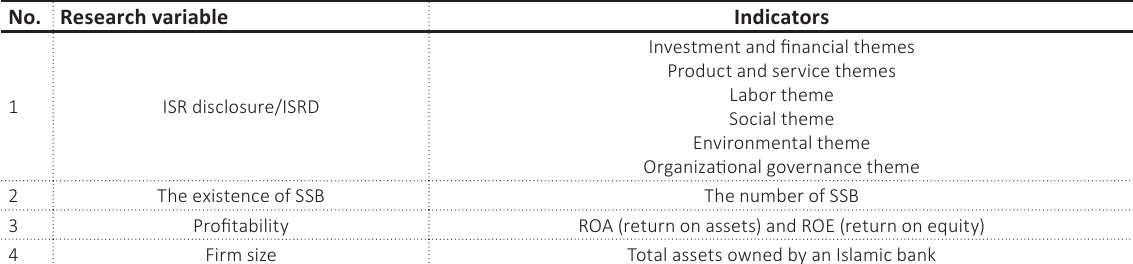
Table 1. Operational definitions of research